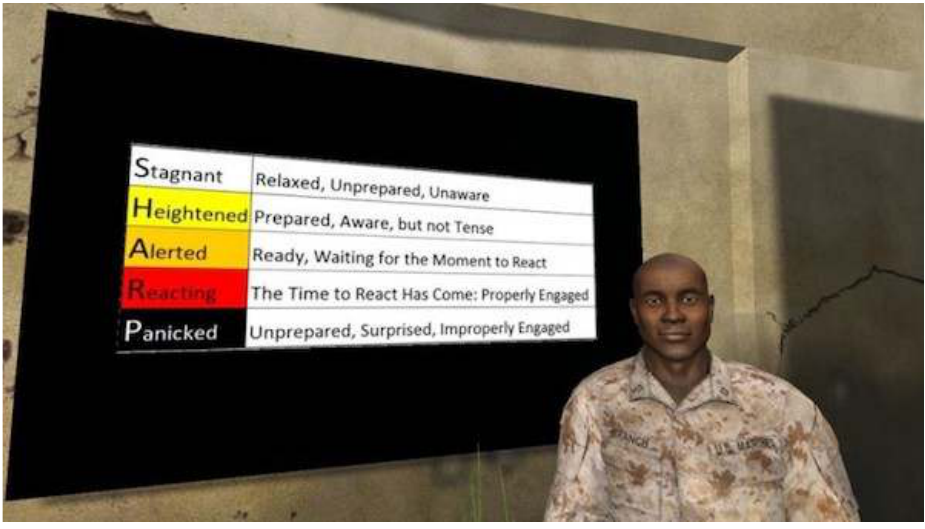
Source: STRIVE Medical Virtual Reality, https://medvr.ict.usc.edu/projects/strive/ © Skip Rizzo,